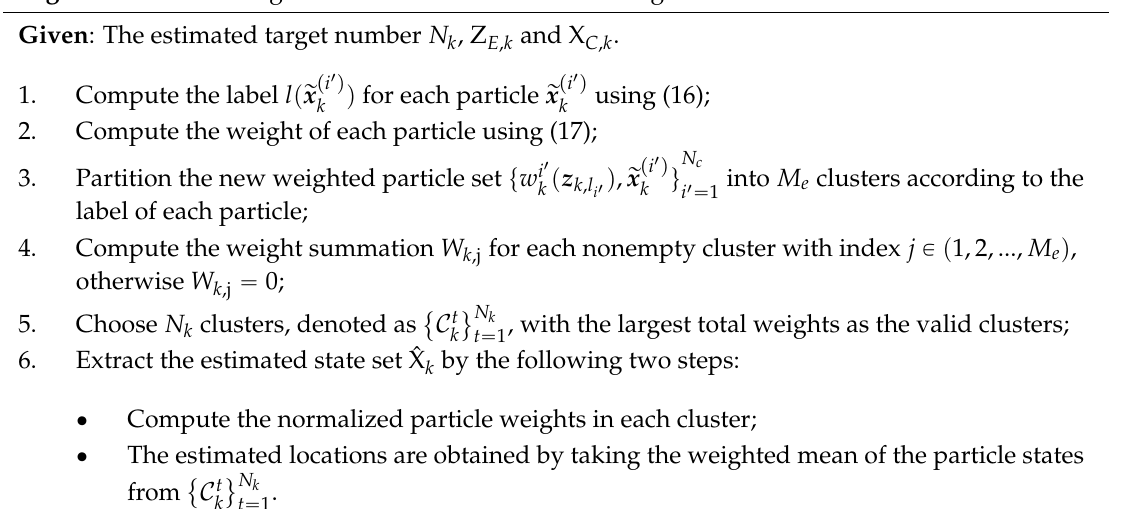
Algorithm 1. Multi-target state extraction for detected